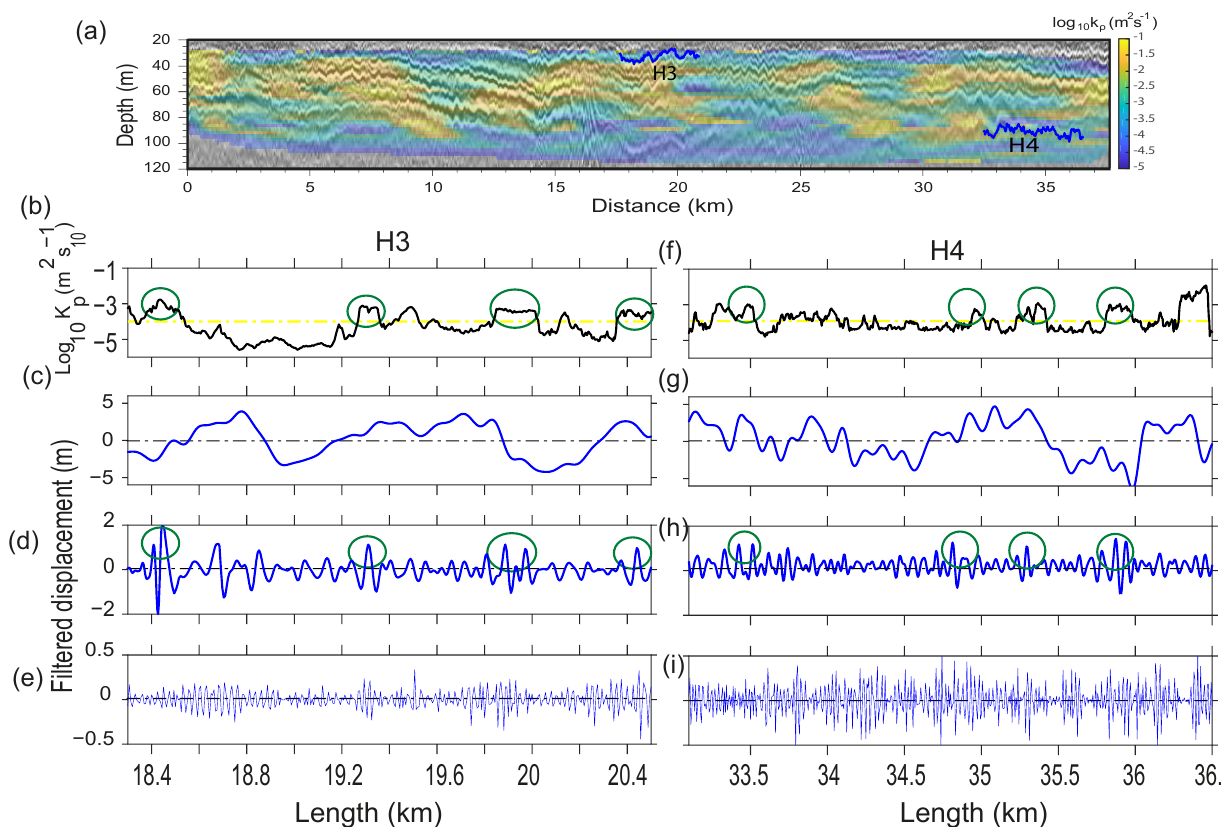
Figure 8. (a) High-resolution k ρ (x,z) map overlapped with the HR-MCS image. Blue lines indicate the locations of the two horizons ana- lyzed (H3 and H4). They have been selected as examples of reflectors crossing lower mixing areas. (b) Diapycnal mixing obtained along H3 (see details of calculation in the text). (c) Signal filtered at wavelength ranges of the IW subrange (3000–100m), (d) the transitional subrange (100–30m), and (e) the turbulent subrange (30–13m). The green circles identify the “diffusion peaks” referred to in the text. (f, g, h, i) Same as (b, c, d, e) but for